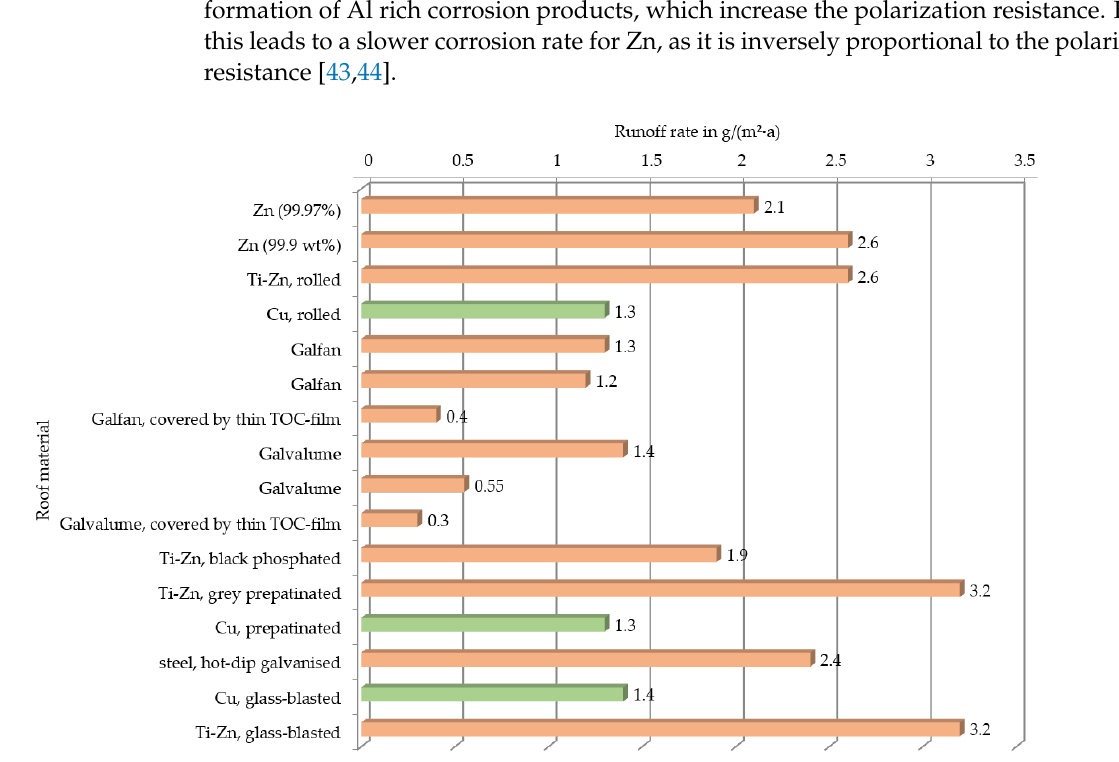
,29 ,43]). roof materials result from different test conditions (data according to ⁠ ⁠